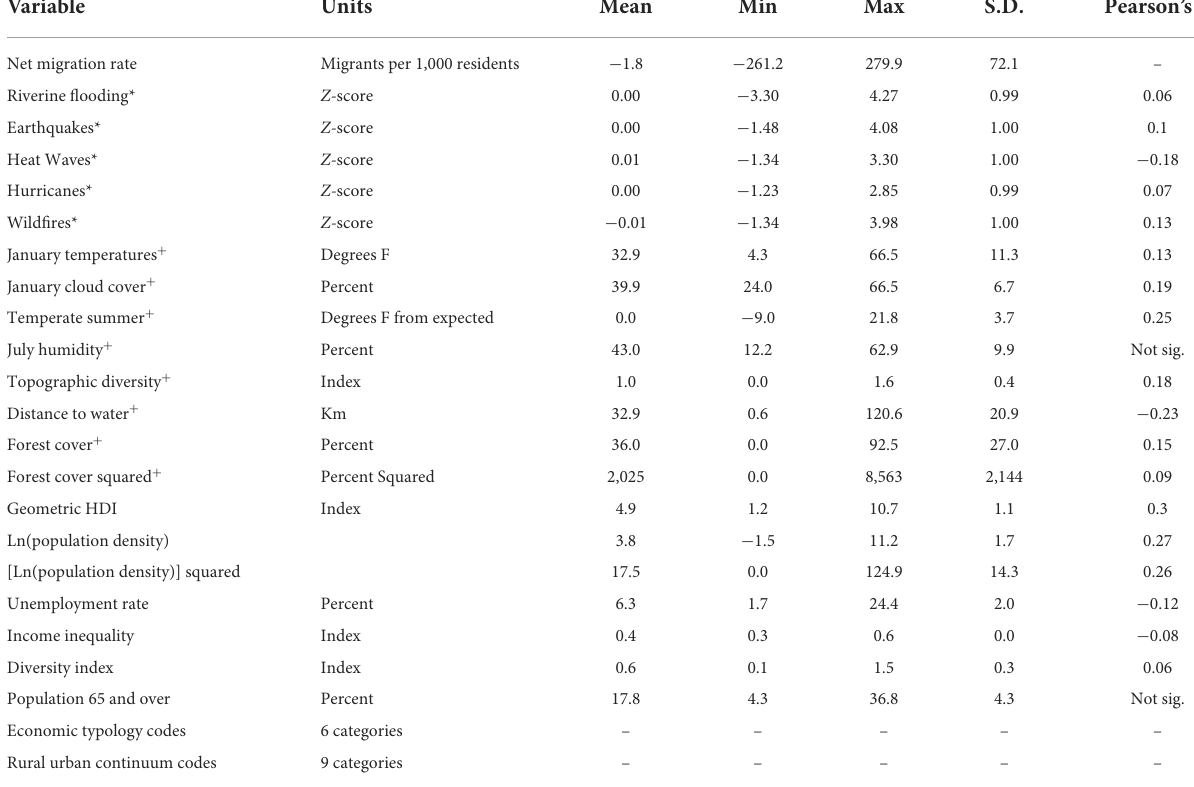
TABLE 1 Summary statistics and correlations with net migration rates.